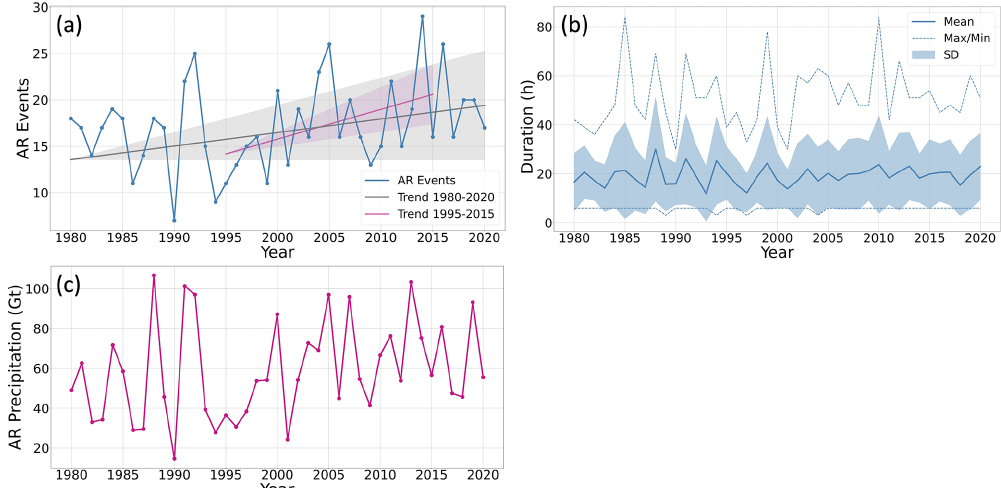
Figure 3. (a) The number of AR events making landfall over the Amundsen Sea Embayment and Marie Byrd Land each year (blue), with the 1980–2020 trend and standard error (gray) and the 1995–2015 trend error (pink). (b) The mean duration of AR events each year (thick blue line), along with the maximum and minimum duration of events (dotted lines) and the standard deviation from the mean (blue shading). (c) The total precipitation attributed to ARs annually from 1980 to